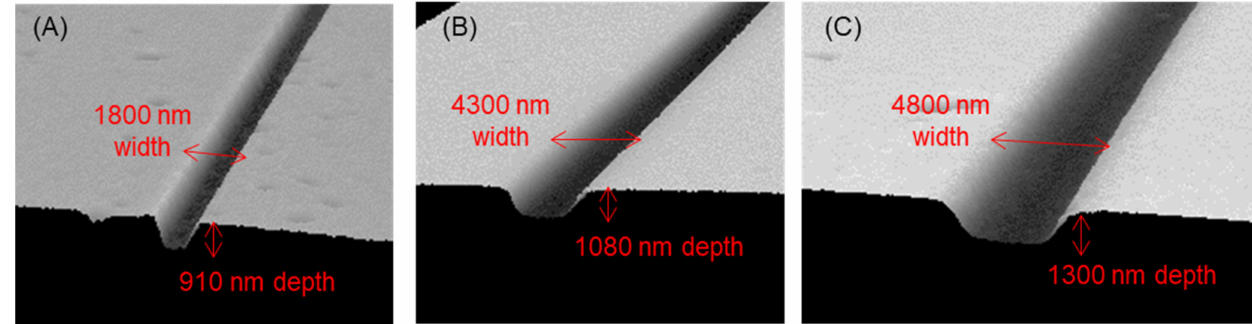
Figure 5. 3D profiles of fabricated extended nanochannels scanned by an optical profiler (WYKO NT9100A). Results for fabrication with ( A ) 1700 nm resist thickness, 1000 nm exposed channel width, and 0.5 µ s exposure; ( B ) 1900 nm resist thickness, 2500 nm exposed channel width, and 0.4 µ s exposure; and ( C ) 2300 nm resist thickness, 3000 nm exposed channel width, and 1.0 µ s